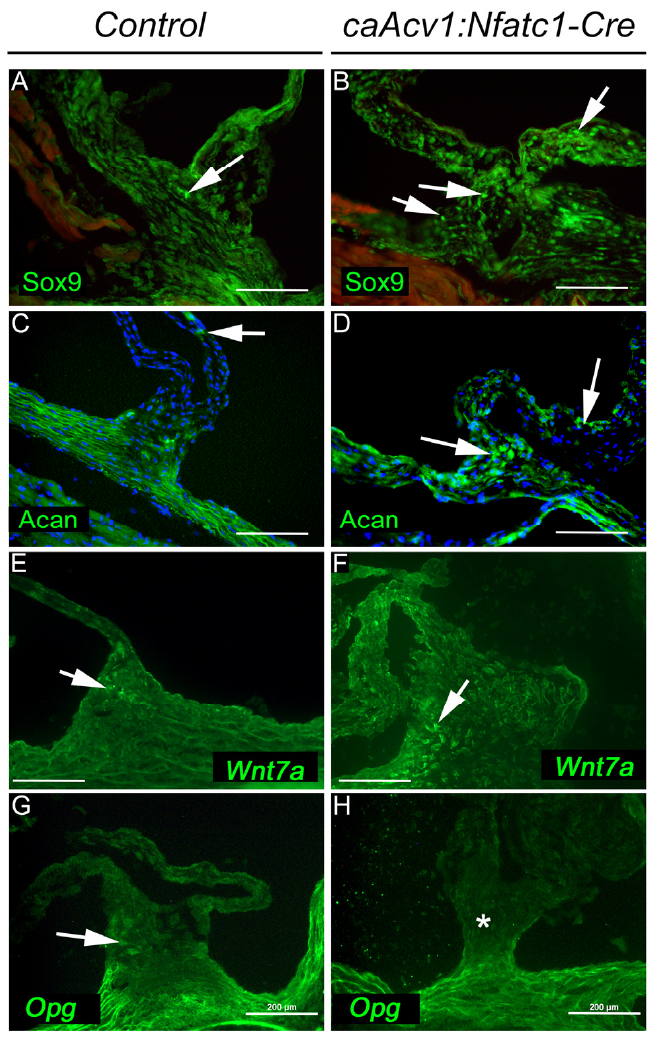
Figure 6. Changes in protein expression and localization in aortic valve tissues between the caAcvr1:Nfatc1Cre mutants and controls. Sox9 increased in nuclear localization (arrows in ( A , B )) in the mutants ( B ) compared with the controls ( A ). The mutant aortic valves showed higher Aggrecan (Acan) protein levels ( D ) than the corresponding control tissues ( C ). Arrows in ( C , D ) point to positive Acan staining. Wnt7a (white arrows in ( E , F )) showed higher levels in the leaflet–wall junction in the mutants ( F ) than in the controls ( E ). Opg protein was less expressed in the mutants (( H ), asterisk) than in the controls (( G ), white arrow). Scale bars, 200 μ m; n = 6.